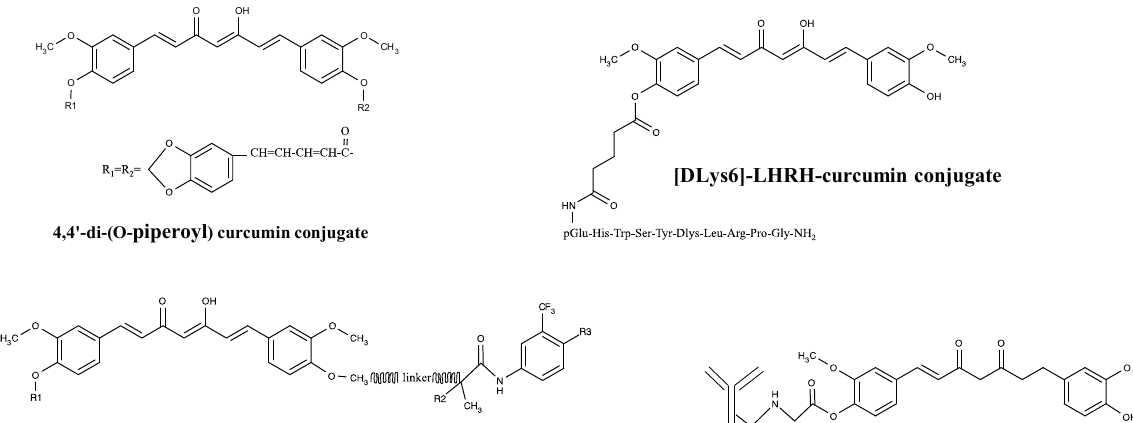
Figure 4. Chemical structure of curcumin hybrid compounds with anticancer properties. LHRH, luteinizing hormone releasing